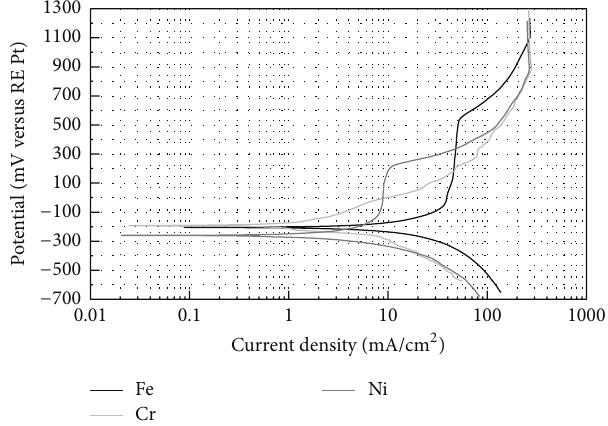
Figure 8: Potentiodynamic polarization curves of Cr, Ni, and Fe obtained under the exposure in NaVO 3 at 700 ∘ C in static air.